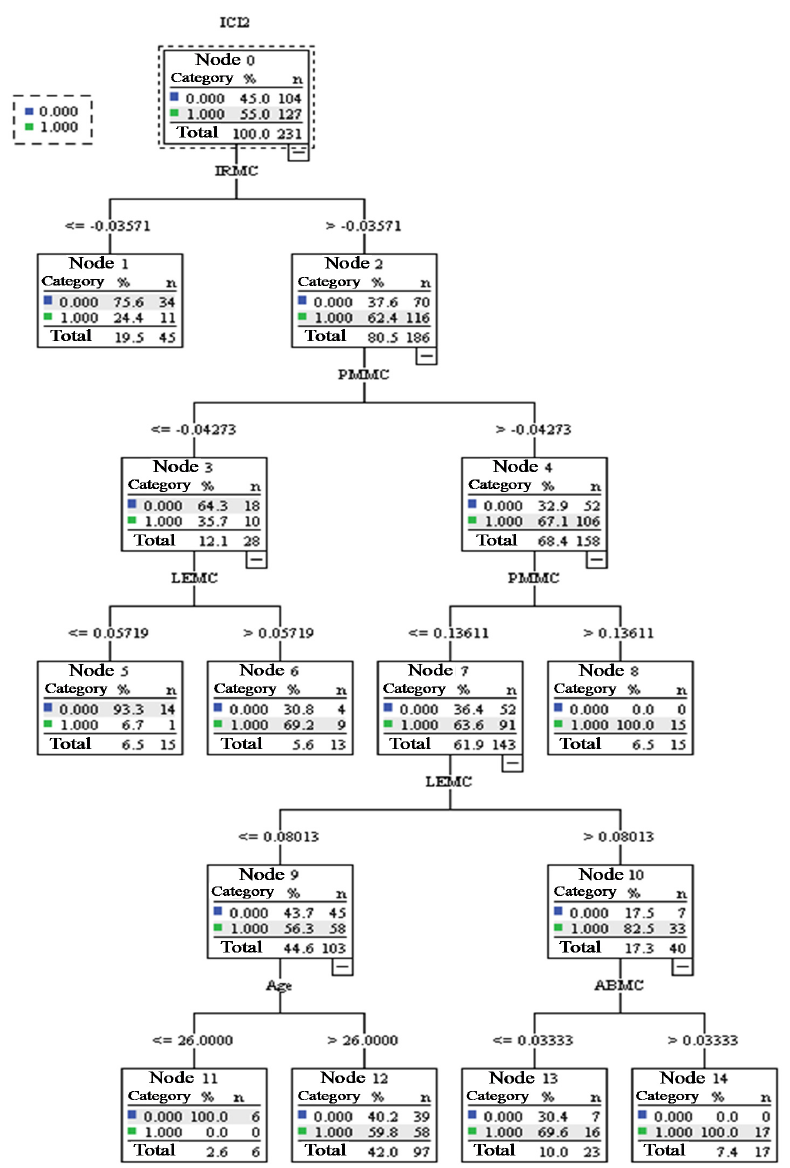
Figure 2. A tree structure pattern that has a better learning effect on the sample after the implemen- tation of the HMEAYC. In Node 0, the sample of 231 people, ICI(N (cid:2893)(cid:2893) ) = 1, has 127 people accounting for 55.0% of the sample. The branches below Node 0 are Node 1 and Node 2 (First layer). In Node 1 (IRMC ≤ − 0.04; 45 people accounted for 19.5% of the sample), 11 participants of the high-impact learning effect ( ICI(N (cid:2893)(cid:2893) ) = 1) accounted for 24.4% of the total number of Node 1; therefore, when IRMC ≤− 0.04 is shown, 75.6% of the participants will have a lim- ited learning effect ( N (cid:2893)(cid:2893) ≤ 3). In Node 2 (IRMC > − 0.04; 186 people accounted for 80.5% of the sample), 116 participants of the high-impact learning effect ( ICI(N (cid:2893)(cid:2893) ) = 1) accounted for 62.4% of the total number of Node 2; this proportion is much higher than the 24.4% at Node 1. Branching down from Node 2 into Node 3 (PMMC ≤ − 0.04; 28 people accounted